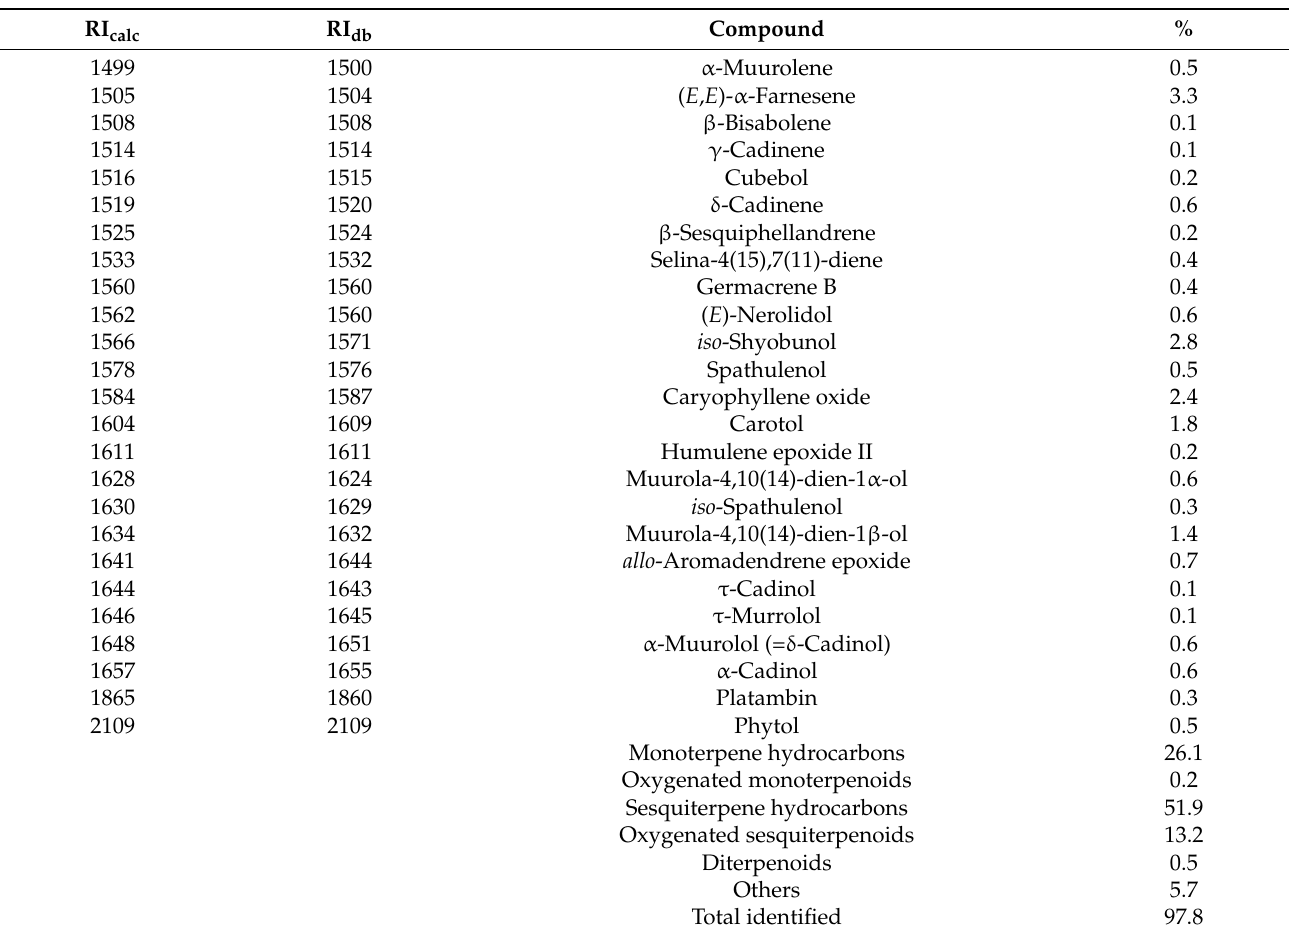
Table 5). In contrast, the S. africanus (as S. indicus ) essential oil from India was composed of thymohydroquinone dimethyl ether (18.2%), α -agarofuran (11.8%), 10- epi - γ -eudesmol (7.9%), and selin-11-en-4 α -ol (12.7%) [55]. The compositional differences in the essential oils from Vietnam and India may be attributed to genetic differences or environmental